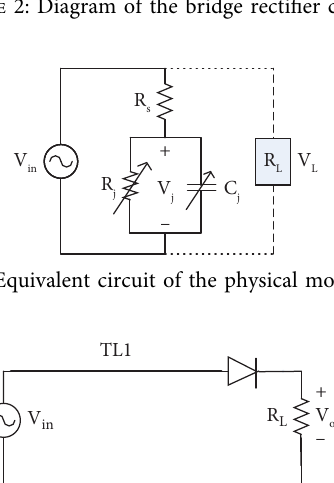
Figure 4: Circuit containing